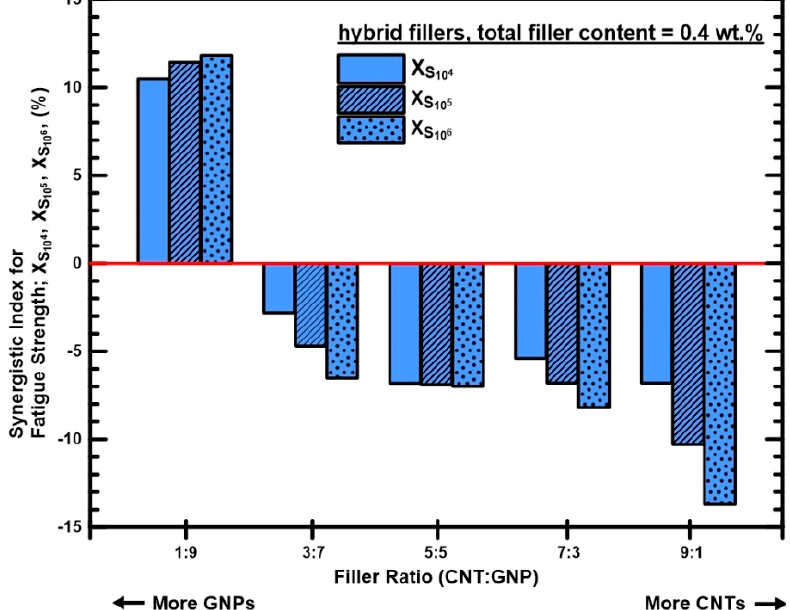
Figure 9. Variation of synergistic indexes χ of the fatigue strengths at 10 4 -, 10 5 -, and 10 6 -cycle lives of the nanocomposites with the employed filler ratios.